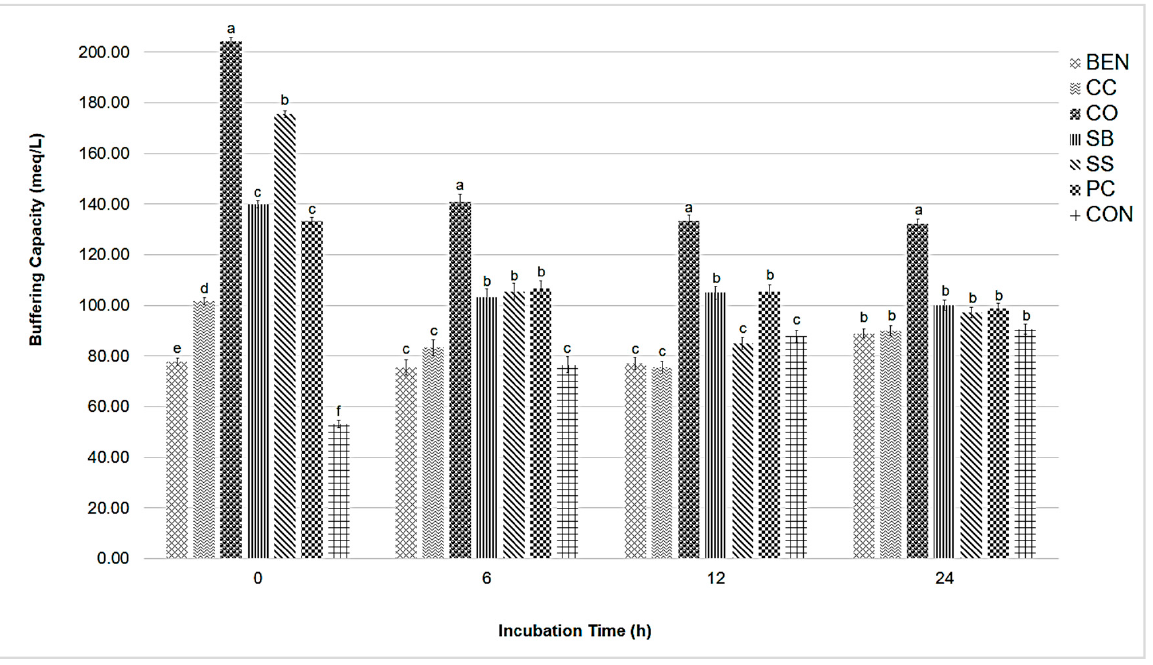
Figure 1. Buffering capacity (meq/L) of treatments during the in vitro rumen fermentation experiment after 0, 6, 12, and 24 h of incubation. BEN, bentonite; CC, calcium carbonate; CO, calcium oxide; SB, sodium bicarbonate; SS, sodium sesquicarbonate; PC, processed coral; CON, control. Superscripts above columns of each buffer ( a–f ) denote significant differences ( p < 0.05).